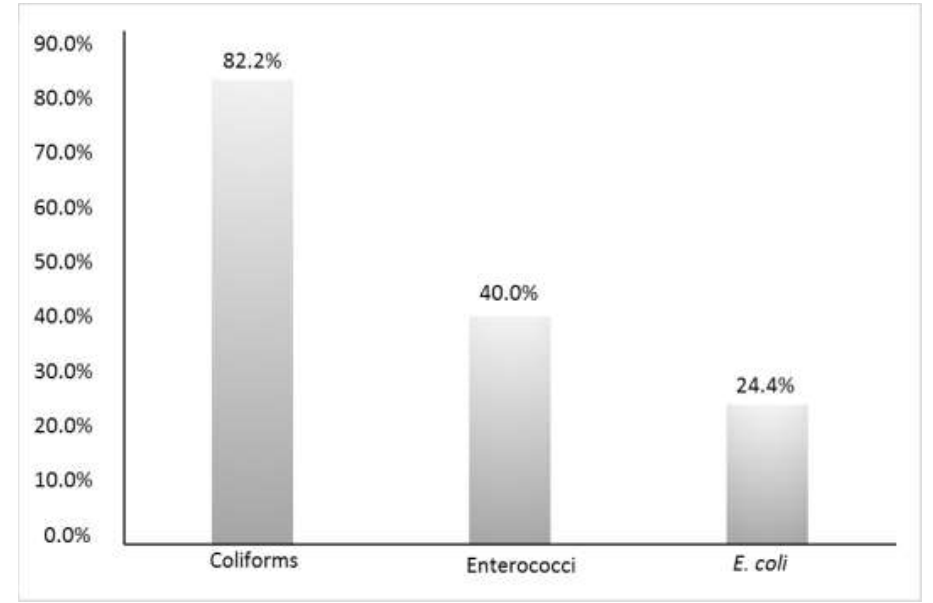
Figure 1. Percentage of non-compliant food ice samples. Samples could be positive to multiple parameters. Table 1. Additional parameters investigated in compliant and non-compliant food ice